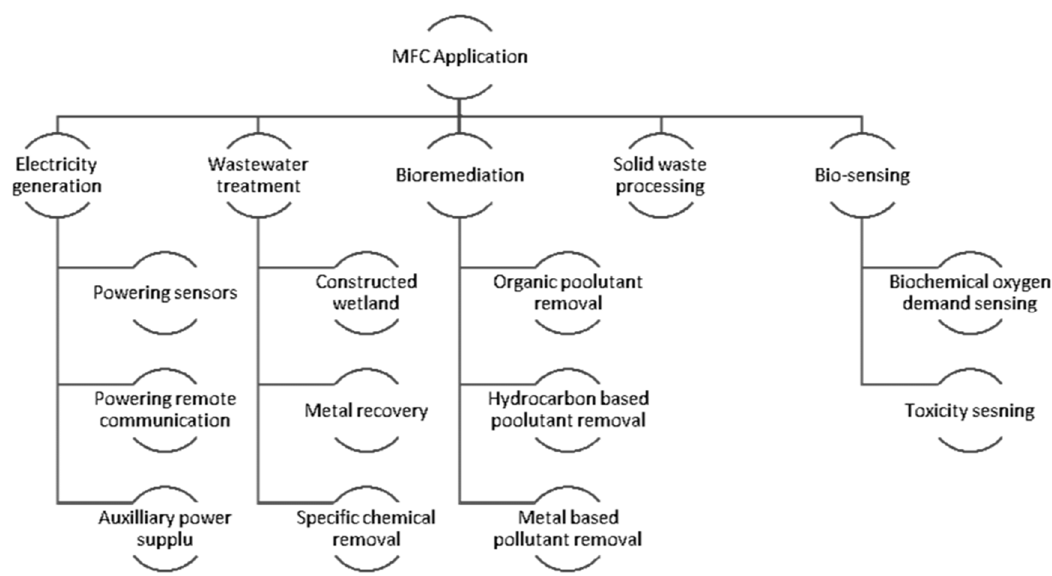
Figure 9. A hierarchical presentation of MFC applications.